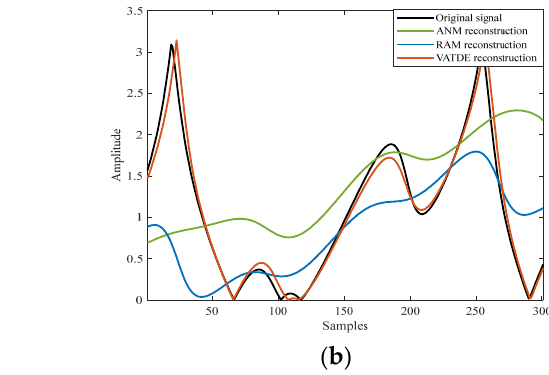
( a ) Time delay estimation result, ( b ) time delay number estimation.